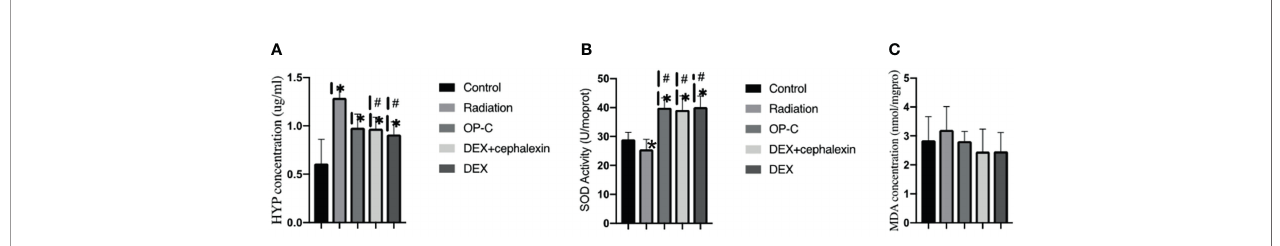
FIGURE 4 | Effects of OP-C on hydroxyproline (Hyp) contents, superoxide dismutase (SOD) activity, and malondialdehyde (MDA) contents in the lungs. Expression of Hyp (A) , SOD activity (B) , and MDA contents (C) in the lungs were measured in mice from the blank control, radiation-only, OP-C, DEX, and DEX + cephalexin groups. The presented data are expressed as the mean ± SEM. *p < 0.05, compared with the control group. # p < 0.05, compared with the radiation-only group.